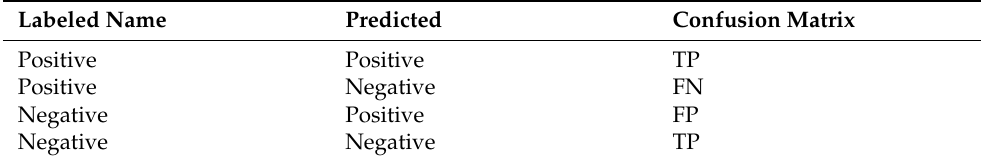
Table 4. The confusion matrix of the real and predicted categories for dichotomous problems. Labeled